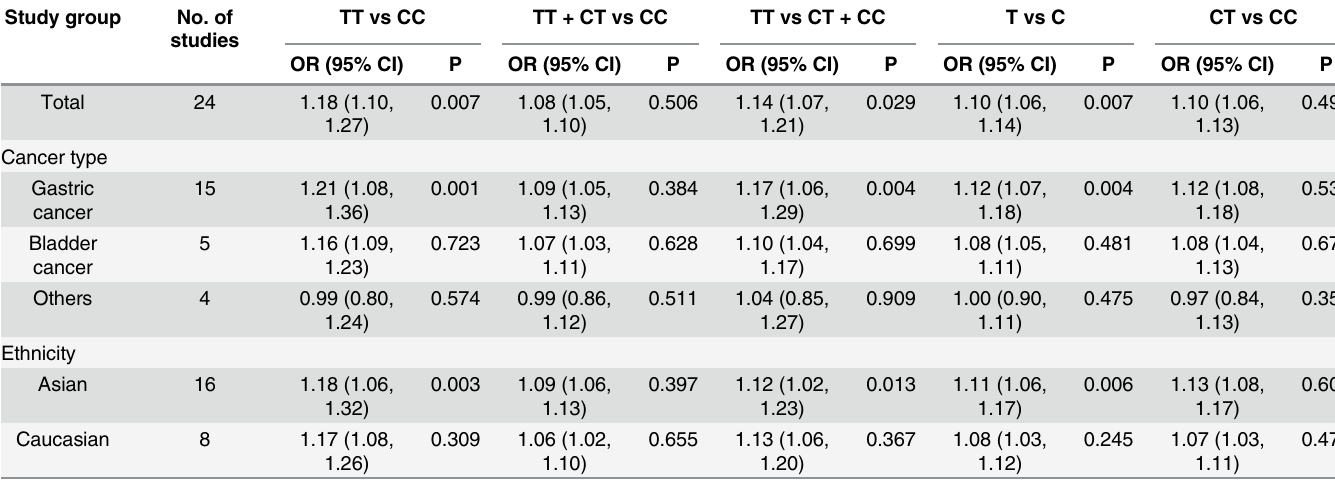
Table 2. Results of meta-analysis for PSCA rs2294008 C > T polymorphism and cancer. P, p value of Q test for heterogeneity. Study group